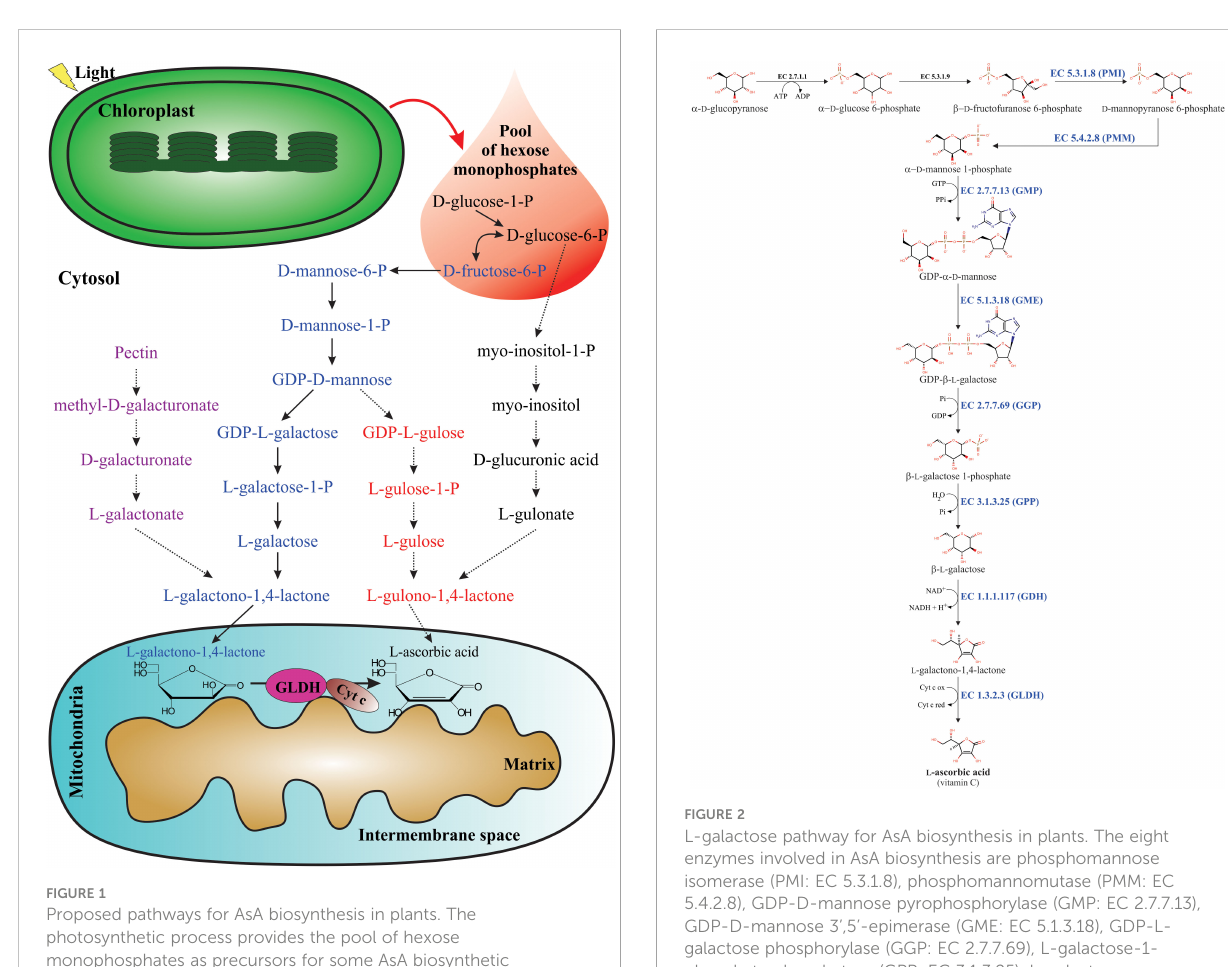
(Figure 2), is best supported by multiple genetic and biochemical studies. From this biosynthetic pathway, the eight genes encoding enzymes were identi fi ed and cloned, and the catalytic activities of the corresponding enzymes have been functionally well- characterized in higher plants. These include phosphomannose isomerase (PMI: EC 5.3.1.8) (Maruta et al., 2008), phosphomannomutase (PMM: EC 5.4.2.8) (Qian et al., 2007), GDP-D-mannose pyrophosphorylase (GMP: EC 2.7.7.22) (Conklin et al., 1999), the GDP-D-mannose 3 ’ ,5 ’ -epimerase (GME: EC 5.1.3.18) (Wolucka and Van Montagu, 2003), the GDP-L-galactose phosphorylase (GGP: EC 2.7.7.69) (Laing et al., 2007), L-galactose-1-phosphate phosphatase (GPP: EC 3.1.3.25) (Laing et al., 2004a), L-galactose dehydrogenase (GDH: EC 1.1.1.117) (Wheeler et al., 1998; Gatzek et al., 2002; Laing et al., 2004b), and L-galactono-1,4-lactone dehydrogenase (GLDH: EC 1.3.2.3) (Mapson and Breslow, 1958; Oba et al., 1995; Ostergaard et al., 1997).